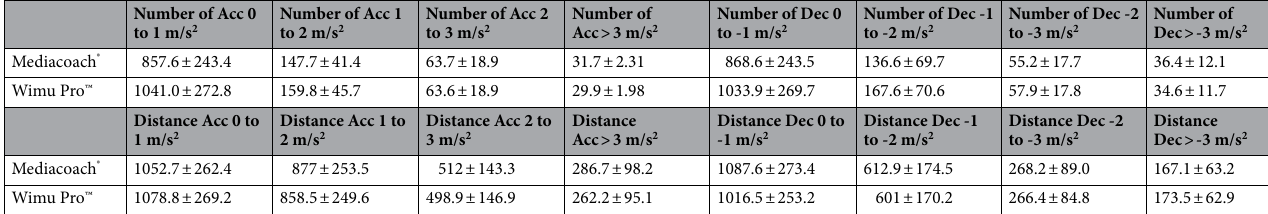
Table 1. Descriptive statistics comparing the data obtained by Mediacoach and Wimu systems. Acc . accelerations, Dec .